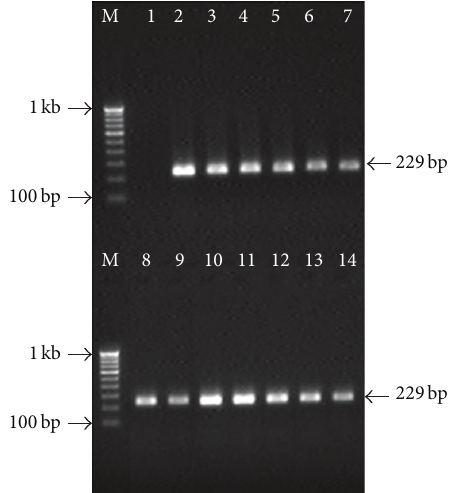
Figure 2: Gel picture showing the nested PCR amplification targeting putative fimbrial protein ( stkG ) gene of S . Paratyphi A in clinical specimens. Lane M, 100bp DNA ladder; lane 1, negative control; lane 2, positive control ( S. Paratyphi A ATCC9150); lanes 3–14, positive nested PCR amplification in clinical samples.